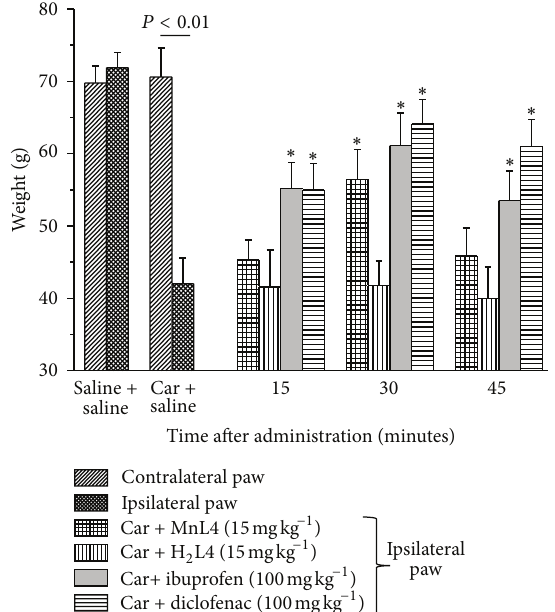
Figure 1: Effect of MnL4, H 2 L4, ibuprofen, and diclofenac on carrageenan-induced acute inflammatory pain. Carrageenan (Car, 1%, 100 𝜇 L) was injected in the left posterior sole 3 hours before pain evaluation by the paw pressure test. Molecules or saline was administered i.p. at time 0 and measures were performed at time 15, 30, and 45min. Values are the mean ± s.e.m. of 6 animals. ∗ 𝑃 < 0.05 versus the ipsilateral paw of carrageenan + saline